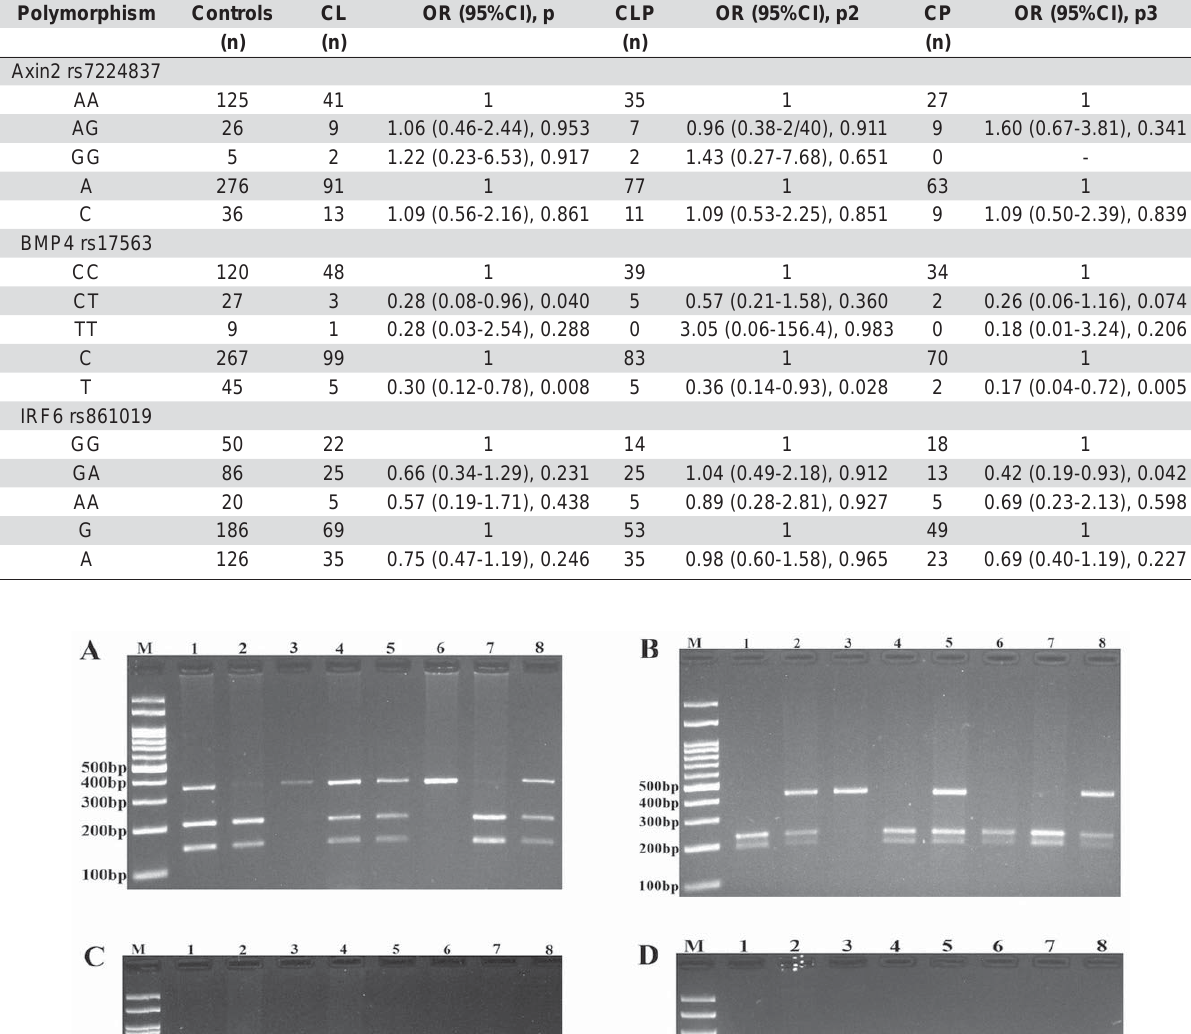
Table 3- Genotype and allele frequencies of AXIN2 rs7224837, BMP4 rs17563, and IRF6 rs861019 gene polymorphisms in subjects with cleft lip (CL), cleft lip with cleft palate (CLP), and cleft palate (CP)